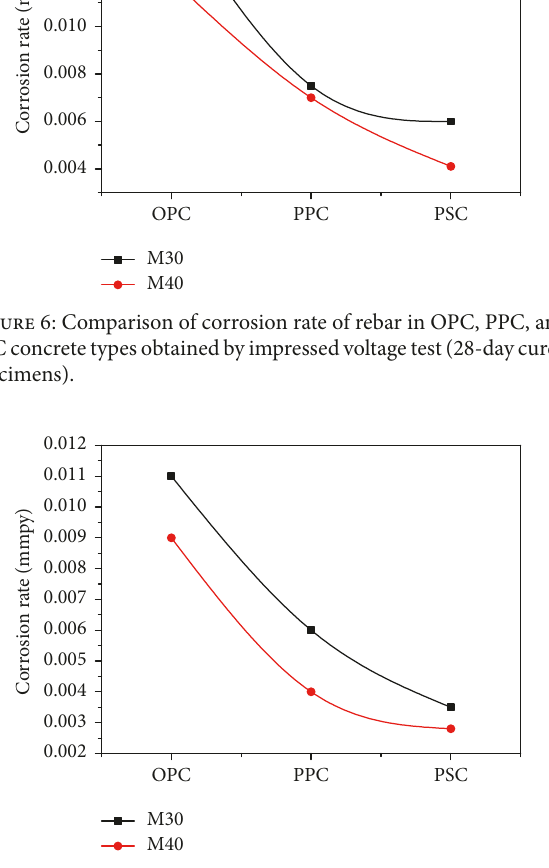
Figure 7: Comparison of corrosion rate of rebar in OPC, PPC, and PSCconcretetypesobtainedbyimpressedvoltagetest(90-daycured